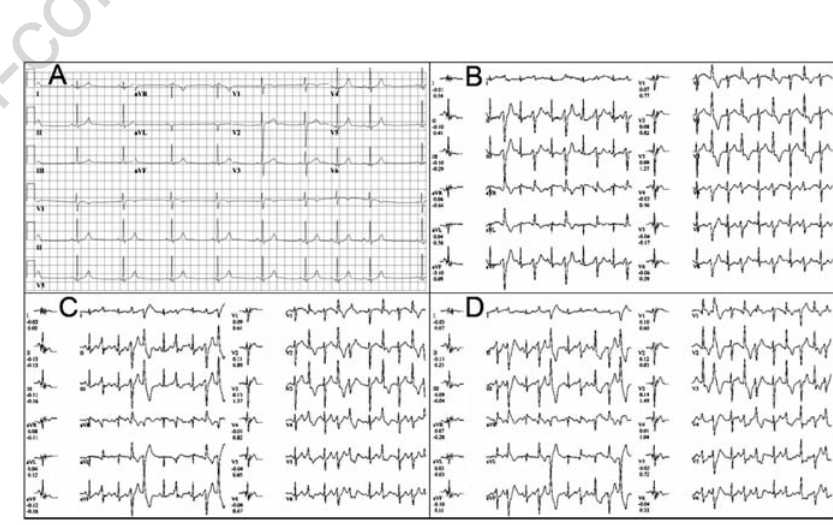
Figure 3. Examples of resting and exercise electrocardiogram (ECG) in a catecholaminer- gic polymorphic ventricular tachycardia (CPVT) patient. A) Resting ECG showing sinus bradycardia. The U-wave in lead V2 and V3 is of moderate amplitude. B-D) Exercise test- ing showing increasing complexity of ventricular arrhythmias. Panel B shows ventricular premature beats in bigeminy, panel C shows polymorphic couplets, and panel D polymor- phic non-sustained ventricular tachycardia of four